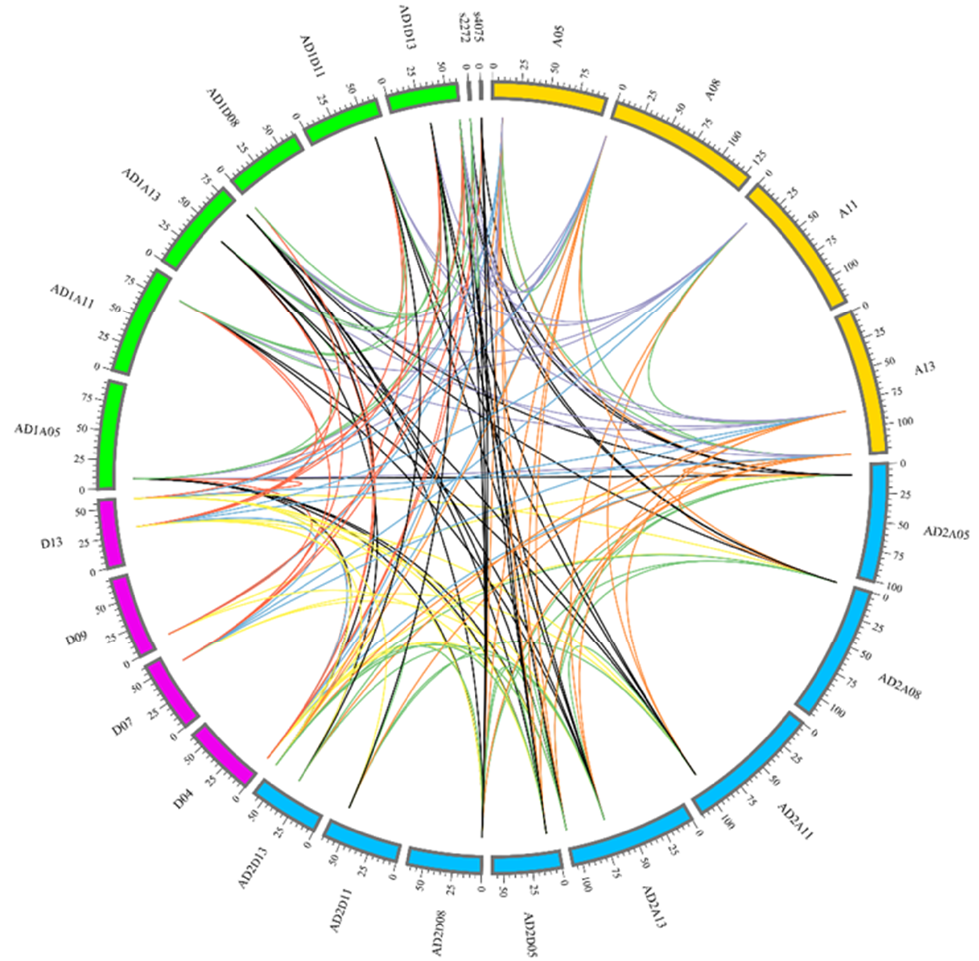
Figure 3. Gene collinearity analysis among cotton NOT2_3_5 genes. AD1AX and AD1DX (green blocks) indicated chromosomes of A sub-genome and D sub-genome of G. hirsutum . AD2AX and AD2DX (blue blocks) indicated chromosomes of A sub-genome and D sub-genome of G. barbadense . AX (yellow blocks) and DX (pink blocks) represented chromosomes of G. arboretum and G. raimondii , respectively. Green lines exhibited duplicated gene pairs among NOT2_3_5 genes in each G. arboretum , G. barbadense , G. hirsutum , G. raimondii cotton species. Orange lines, blue lines, red lines, yellow lines, purple lines and black lines separately exhibited duplicated gene pairs among NOT2_3_5 genes from and G. arboretum and G. barbadense , Gossypium arboretum and G. raimondii , G. hirsutum and G. raimondii , G. raimondii and G. barbadense , G. hirsutum and G. arboretum , G. barbadense and Gossypium arboretum.